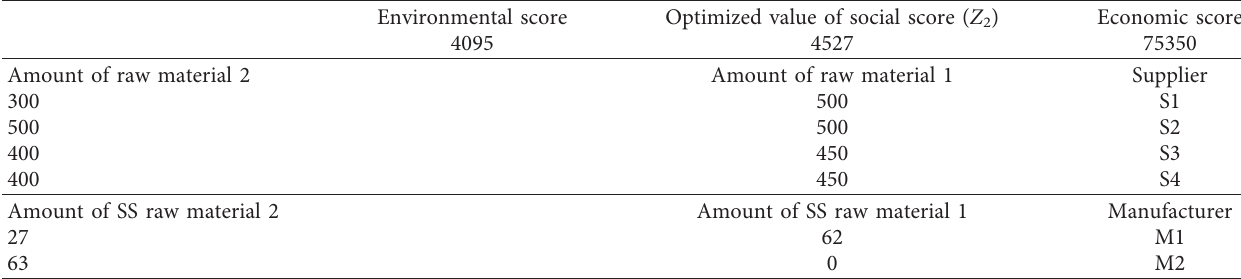
Table 6: Value of objective functions and supply portfolio by optimizing Z